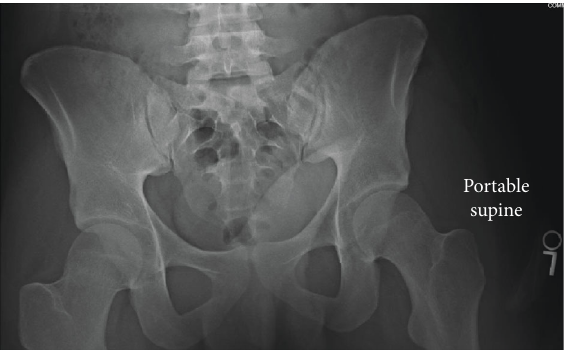
Figure 5: 6-month postoperative anteroposterior X-ray of the pelvis. This radiograph demonstrates complete excision of the exophytic mass from the patient ’ s left iliac wing without any sign of recurrence (Osteochondroma 6 month post-op follow